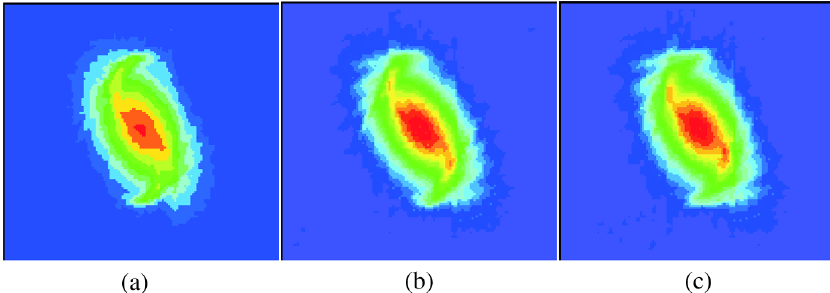
FIG. 4. (Color) Y - Y 0 tomographic recovery of the phantom phase-space distribution using simulated angular and scale errors.